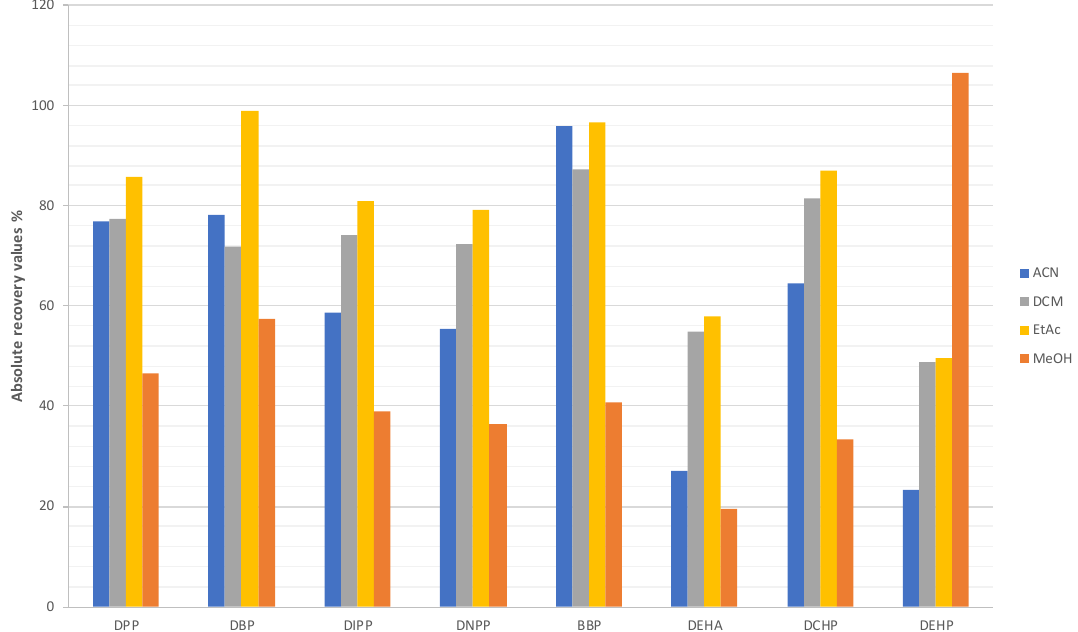
Figure 2. Absolute recovery values obtained with ACN, DCM, EtOAc, and MeOH during extraction procedure optimization.